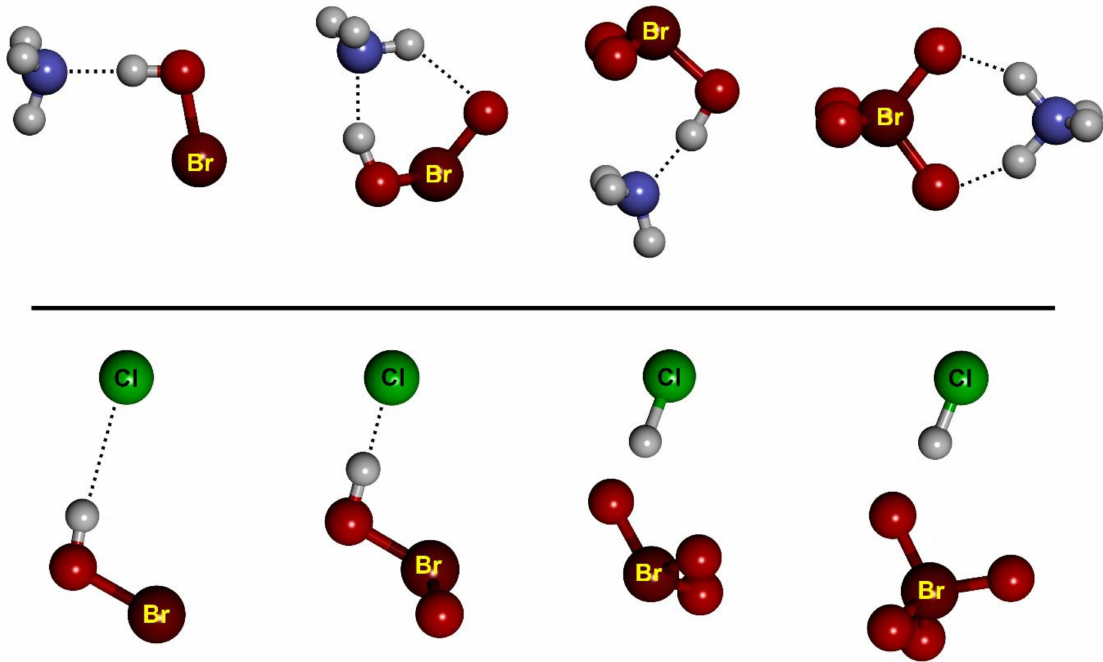
Figure 2. The optimized structures of the HB complexes between HBrO n and NH 3 , and between HBrO n and Cl −